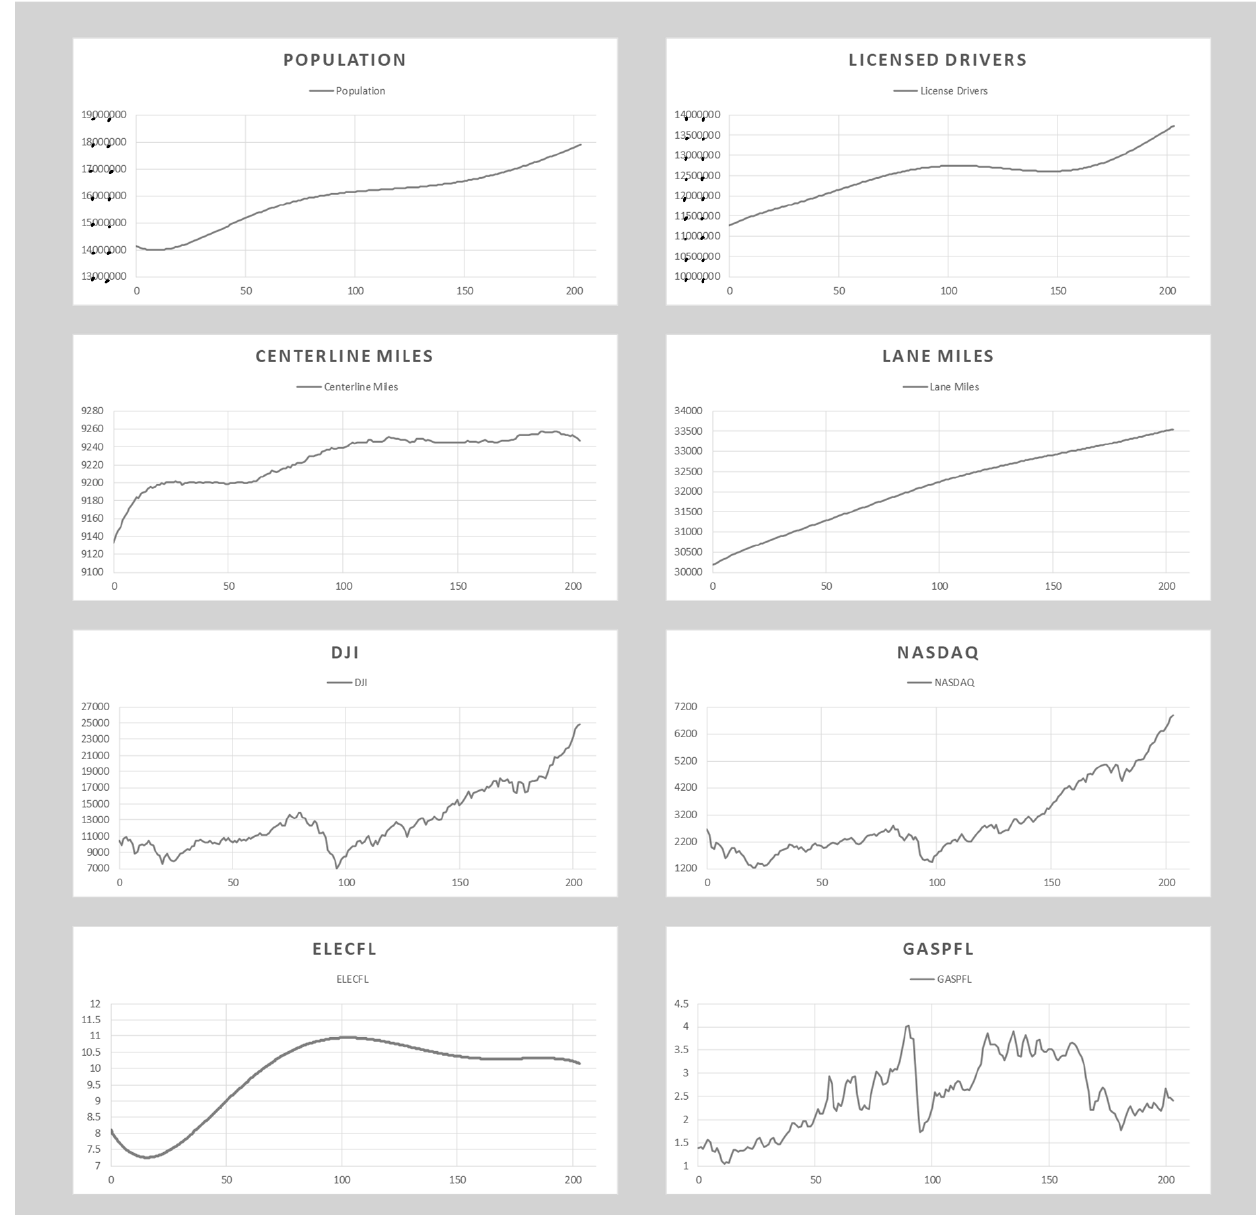
Figure 2. Samples trends from the potential indicators of car traffic counts.